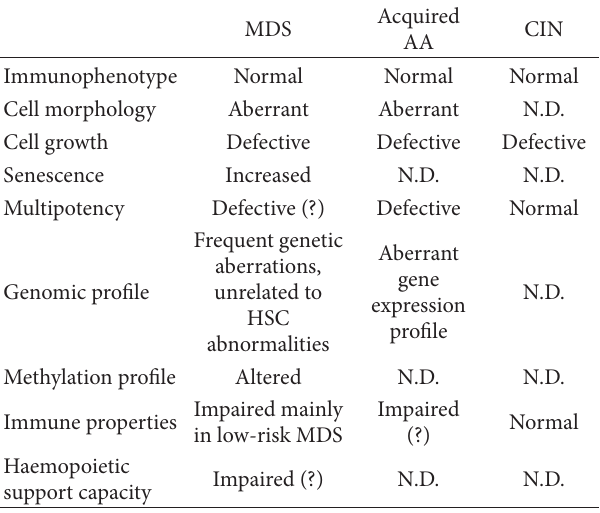
Table 3: Summary of BM MSC characteristics in MDS, acquired AA, and CIN